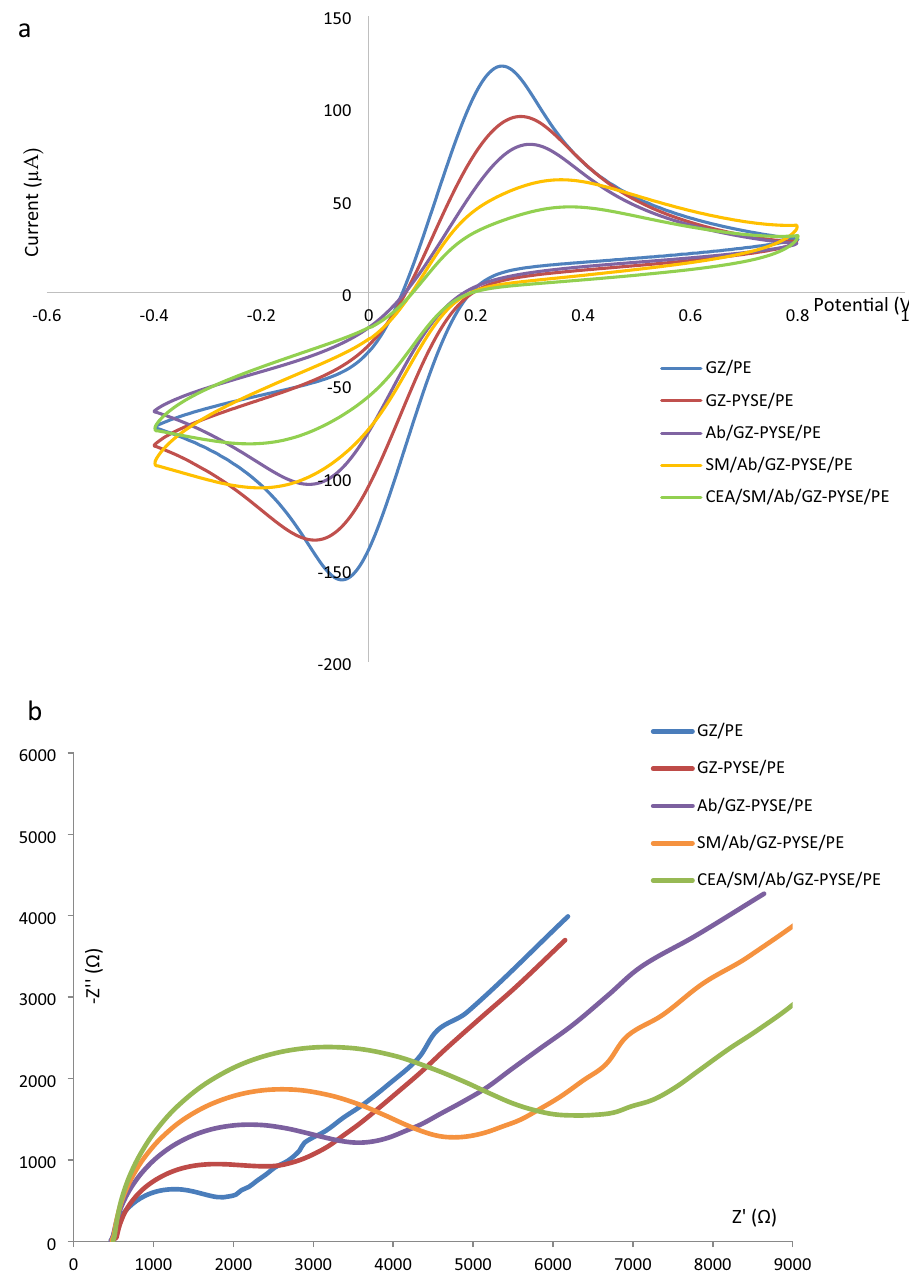
Figure 5. ( a ) CVs and ( b ) EIS of GZ/PE, GZ-PYSE/PE, Ab/GZ-PYSE/PE, SM/Ab/GZ-PYSE/PE and CEA/SM/ Ab/GZ-PYSE/PE. Each functionalization step introduced a higher physical barrier at the electrode surface and increased the charge transfer